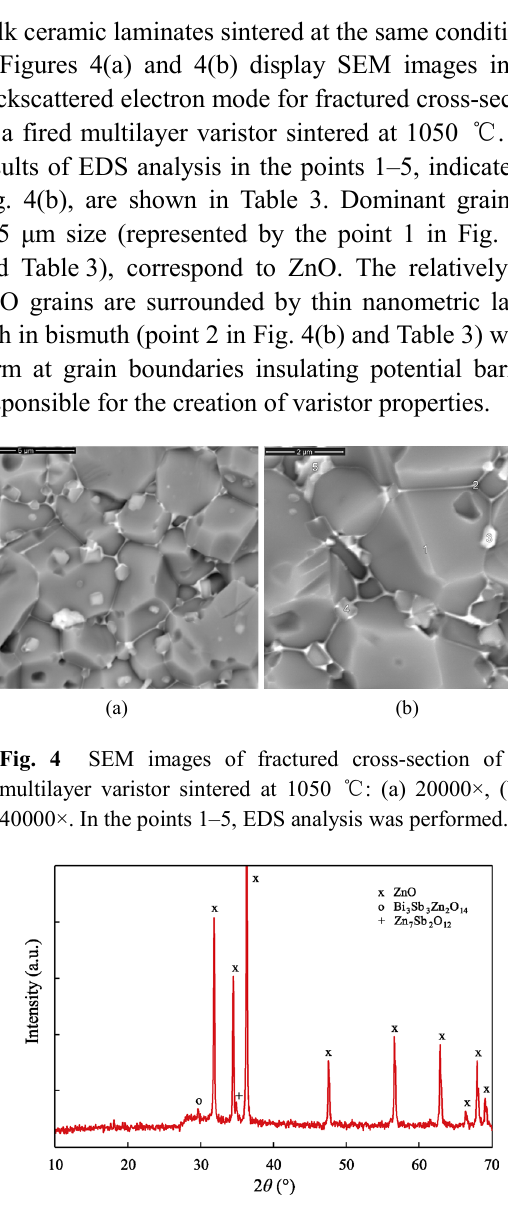
Fig. 5 XRD pattern of the varistor ceramic layer sintered at 1050 ℃ .